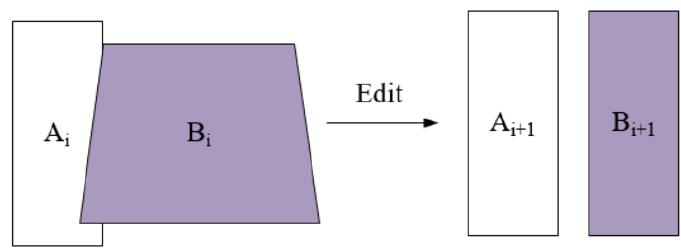
Figure 5. Graph of geometric changes affect topological diagrams.